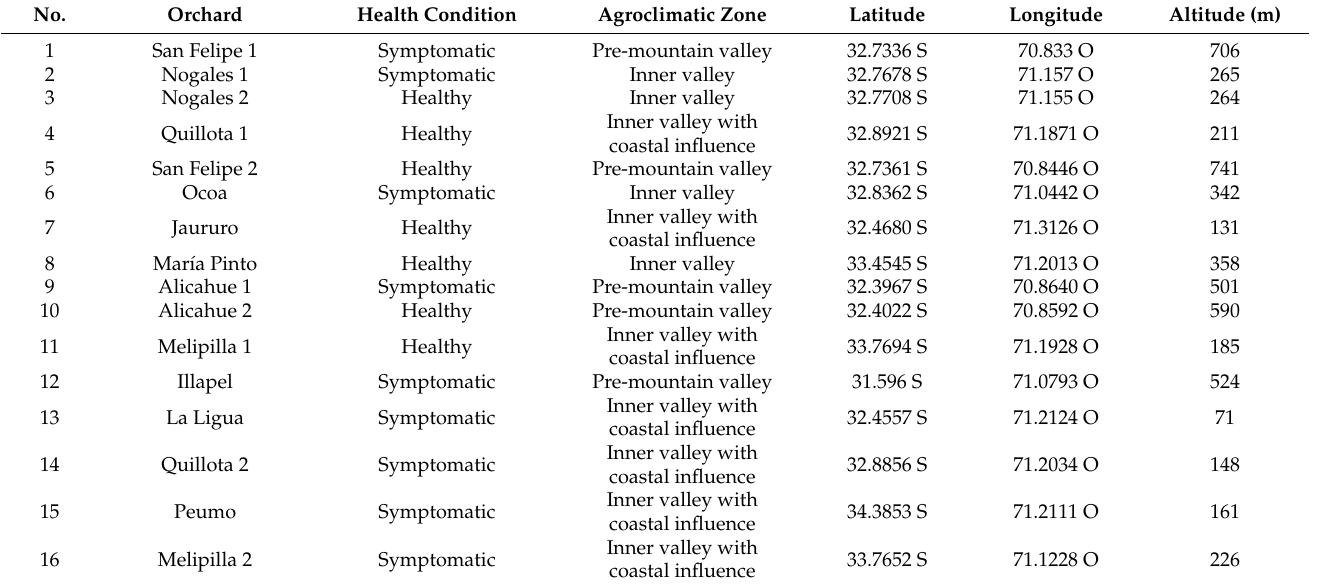
Table 1. A summary description of the health conditions, agroclimatic zones, and geographic locations of the 16 studied orchards based on the classification of P é rez and Adonis